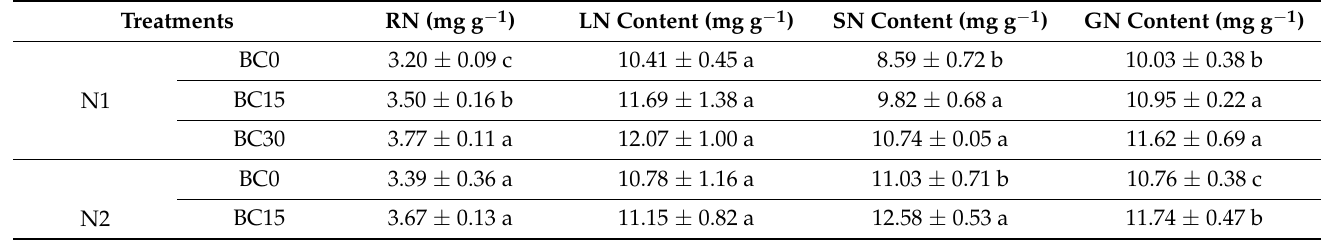
Table 3. Changes in nitrogen contents of roots, leaves, stems and grains of maize under different nitrogen fertilizer and biochar